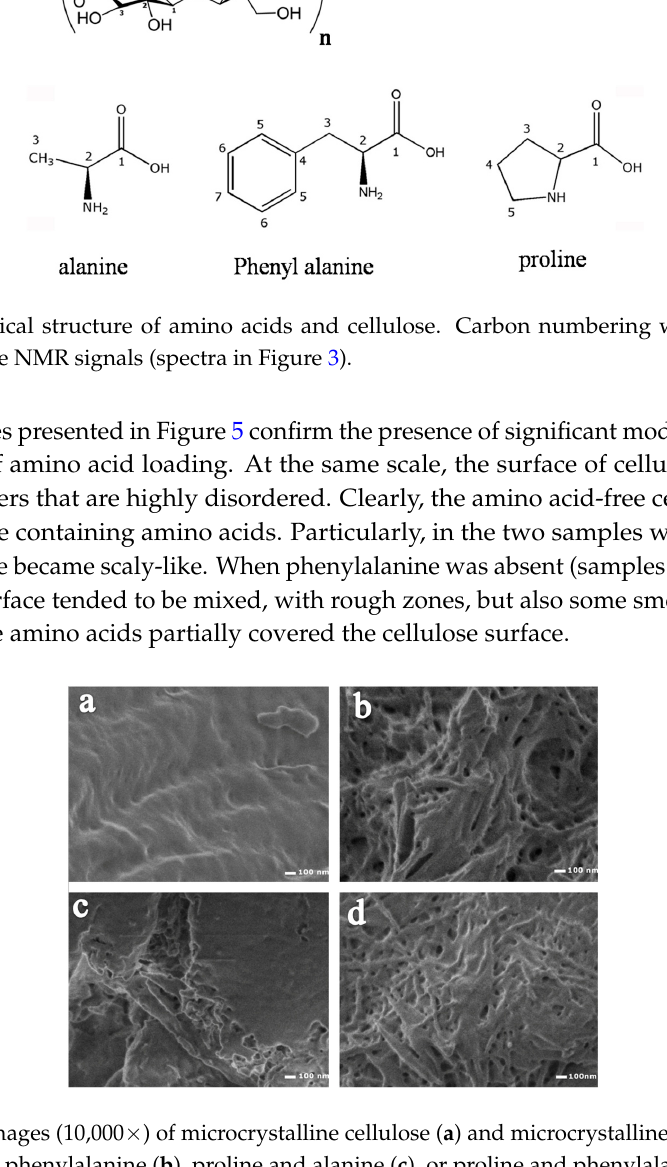
Figure 3. 13 C CP MAS NMR spectra of microcrystalline cellulose and microcrystalline cellulose loaded with amino acids.